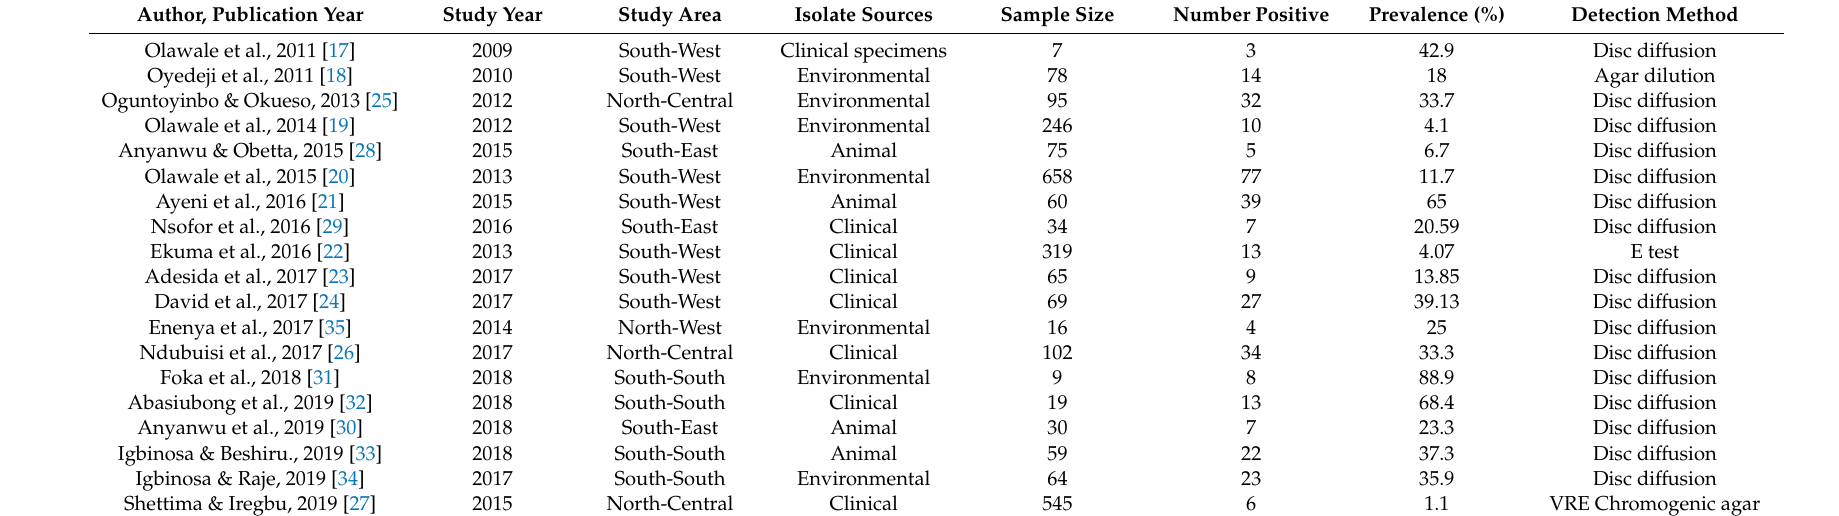
Table 1. Characteristics of the selected studies reporting prevalence of Vancomycin-Resistant Enterococci (VRE) in Nigeria.